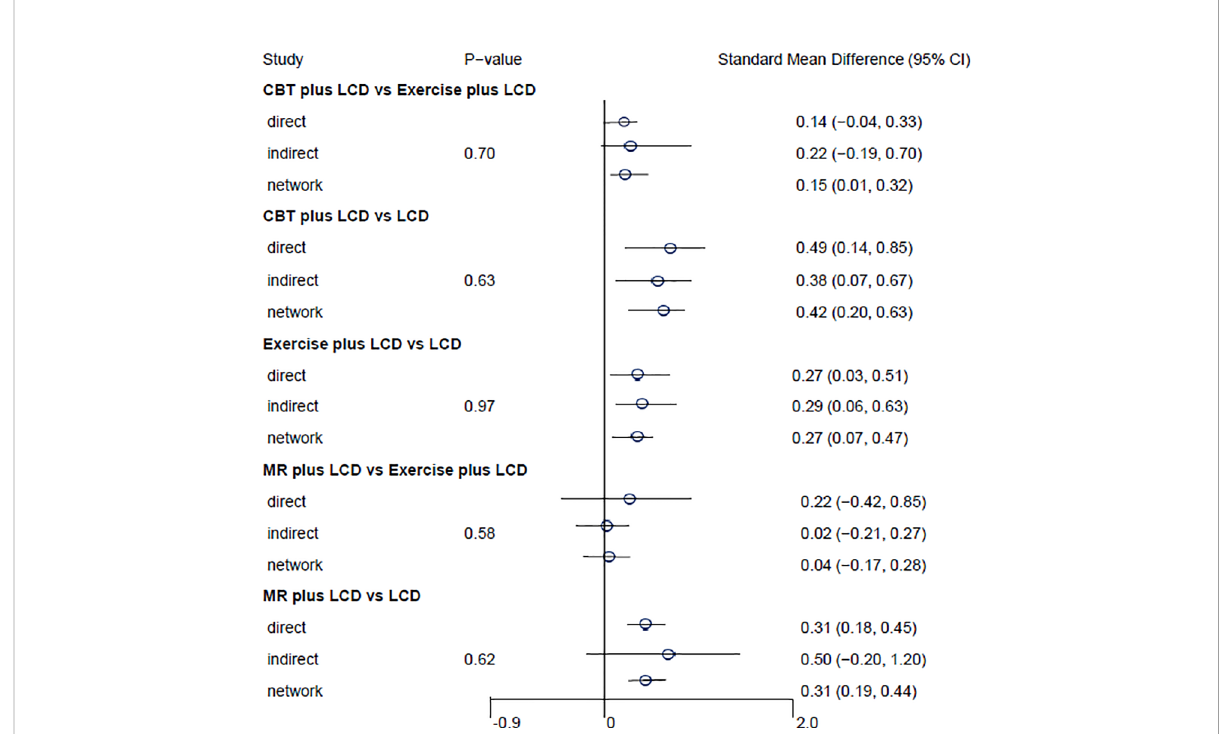
FIGURE 3 Forest plots of the fi ve lumped interventions. LCD, low-calorie diet; CBT, cognitive behavioral therapy; MR, meal replacement.